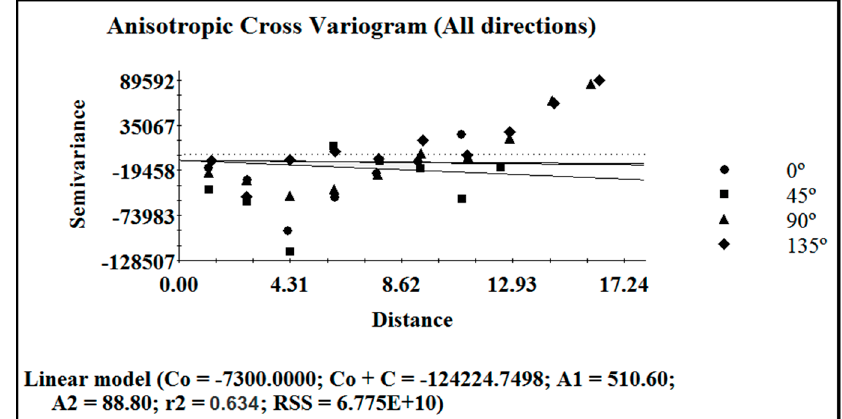
Figure 9. Spatial correlation between the elevation and rainfall. Linear cross-variograms (dots) and measured spherical models (solid lines). The dashed lines show that there is a positive relationship between observed variables. Variogram factors: nugget variance or C 0 ; Sill or C 0 + C ; Range or A ( A 1— the range parameter for the major axis of variation and A 2—the range parameter for the minor axis); Ratio C / ( C 0 + C ) or RNS and RSS. The linear anisotropic model describes a straight-line variogram